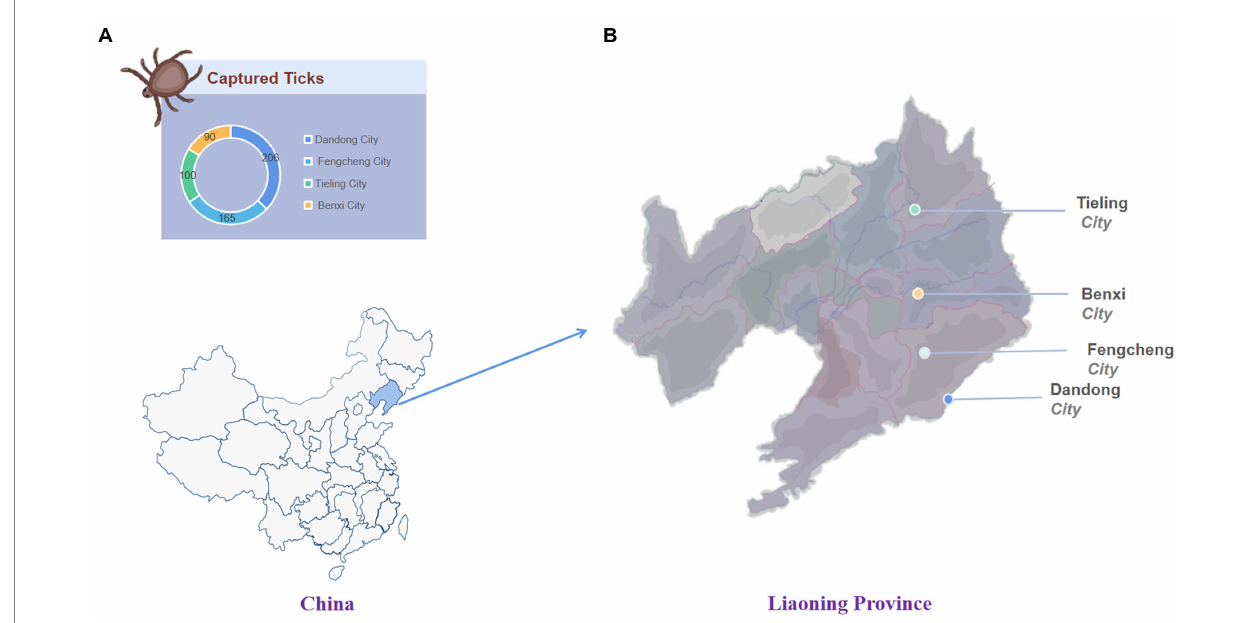
FIGURE 1 The number and location of ticks collected. (A) The number of ticks captured in each area. (B) Tick collection area in Liaoning